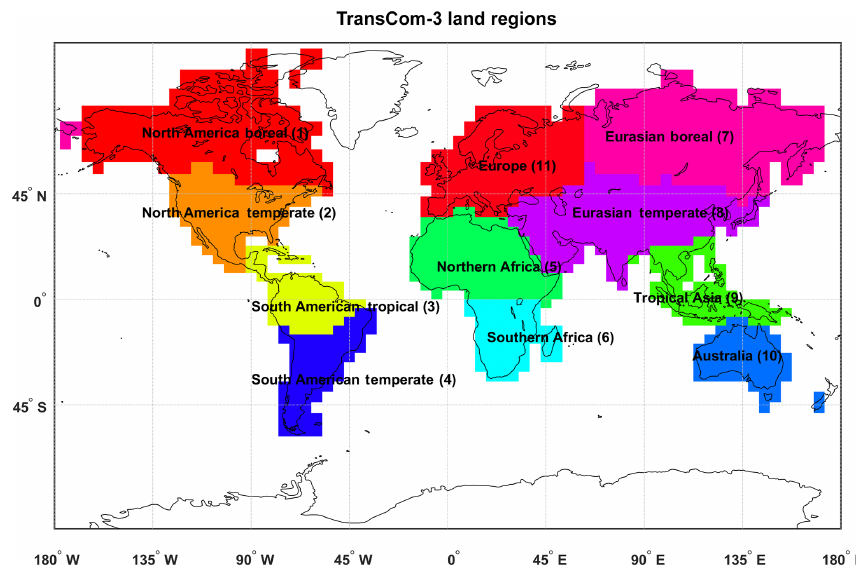
Figure 1. The TransCom-3 land region boundaries used to aggregate CO 2 fluxes for